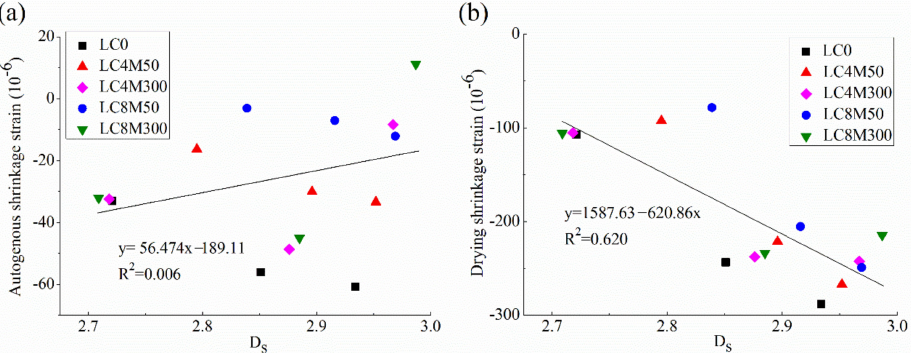
Figure 8. Correlation of D s with ( a ) autogenous shrinkage and ( b ) drying